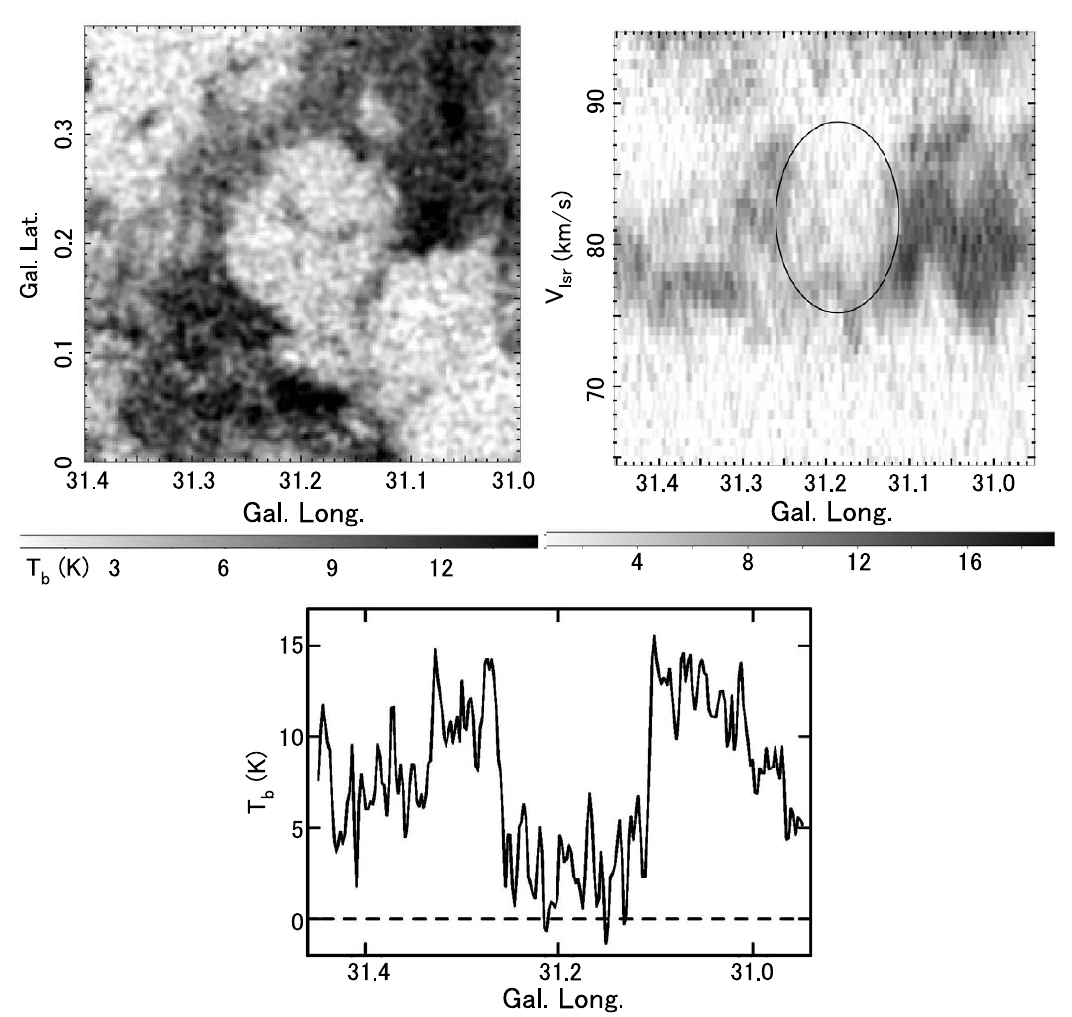
Figure 3. ( Top left ) Molecular bubble S31.2+0.2 at 81.465 km s − 1 . ( Top right ) Longitude-velocity diagram around b = 0 ◦ .23 across the bubble G31.2+0.2 (average of 4 channels in the latitude direction near the bubble center). The ellipse represents bubble radius 0 ◦ .074 (7.1 pc at 5.5 kpc distance) and half velocity width 6.7 km s − 1 centered on l = 31 ◦ .19, v lsr = 81.9 km s − 1 . ( Bottom ) T B cross section at 81.0 km s − 1 across the bubble center at position angle of 120 ◦